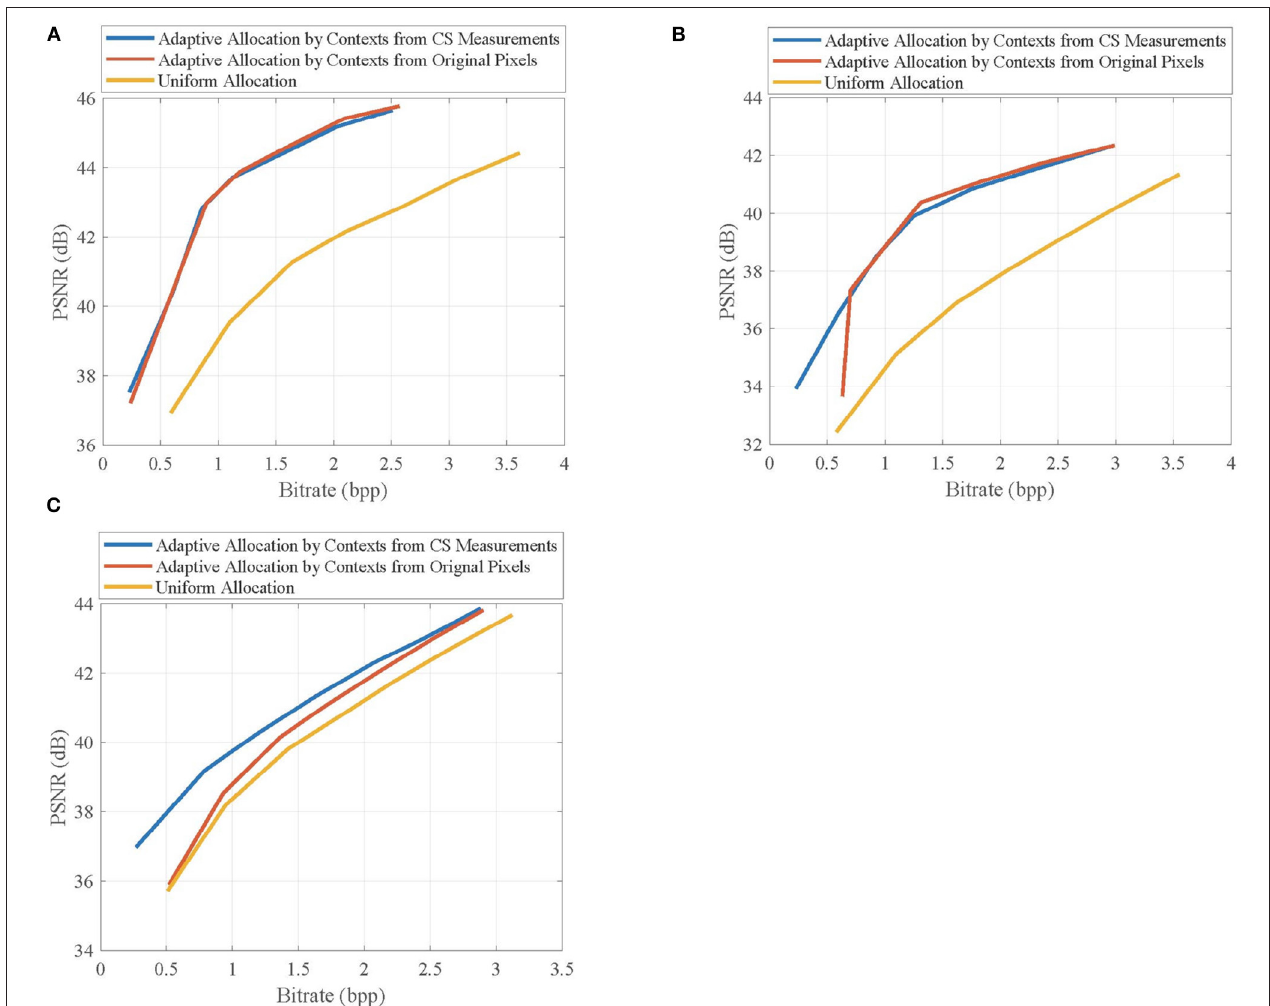
FIGURE 10 | Rate-distortion curves of the reconstructed non-key frames in (A) Foreman , (B) BlowingBubbles , and (C) ParkScene sequences when using different allocation schemes. For Foreman and BlowingBubbles , the block-size pair is set to be (2,16), and for ParkScene , the block-size is set to be (8,16).